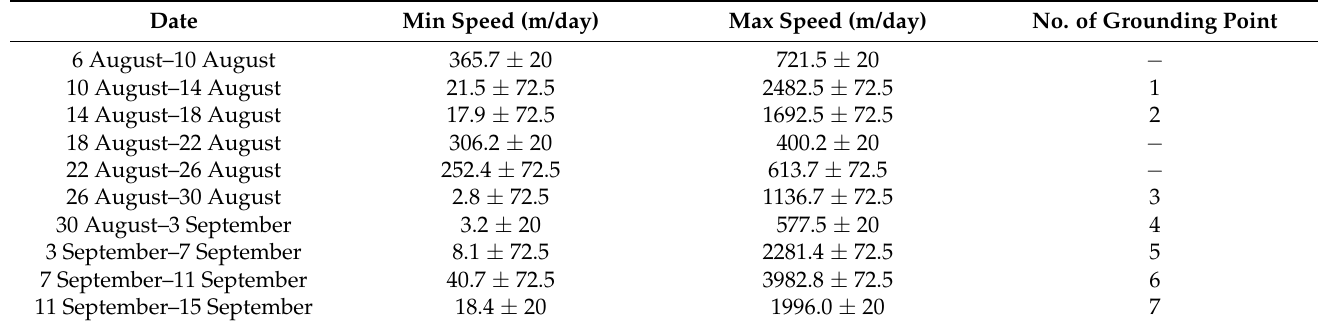
Table 2. The iceberg’s moving speed range every four days from 6 August to 15 September